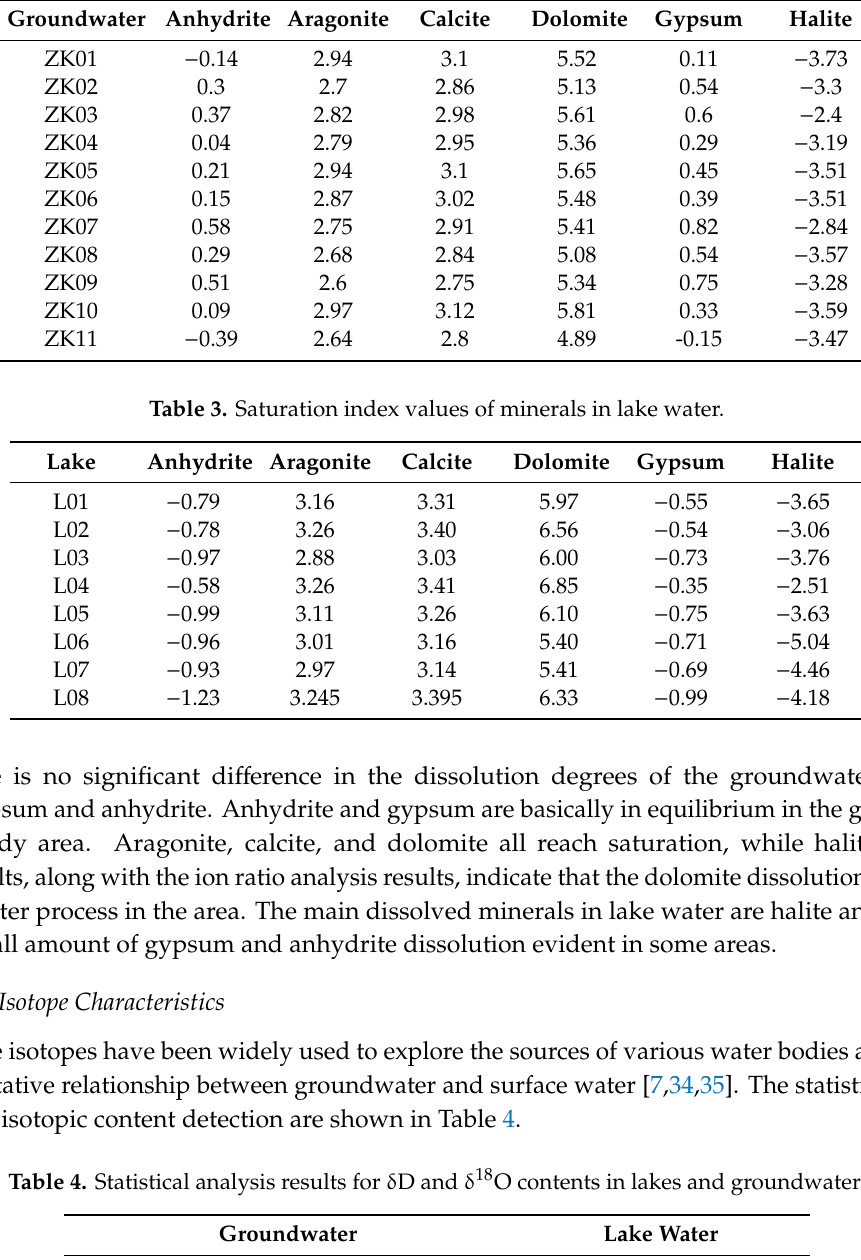
Table 2. Saturation index values of minerals in groundwater.